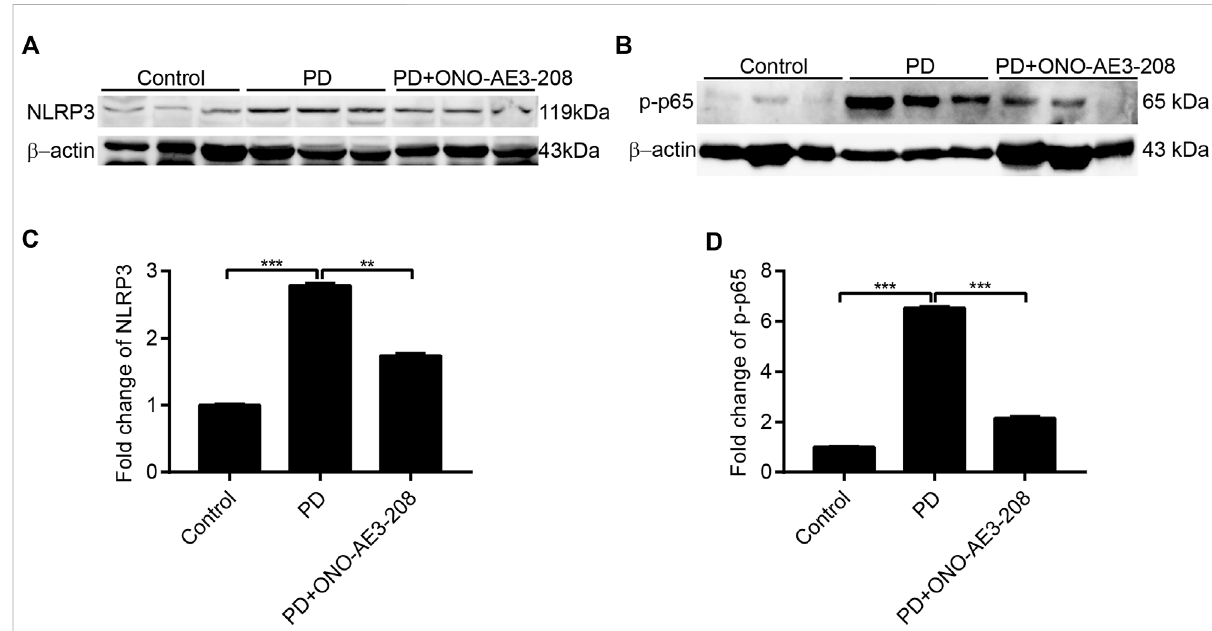
FIGURE 7 Administration of ONO-AE3-208 inhibited NLRP3 in fl ammasome activation and NF- κ B phosphorylation in a rat model of peritoneal dialysis. (A,B) Peritonealtissuelysatesfromeachanimalgroupweresubjectedtowesternblottinganalysiswithspeci fi cantibodiesagainstNLRP3,p-p65,and β -actin. (C,D) Expression levels of NLRP3 and p-p65 were quanti fi ed by densitometry, normalised with β -actin, and presented as fold changes. Data are presented as mean ± SEM. ** p < 0.01, *** p <